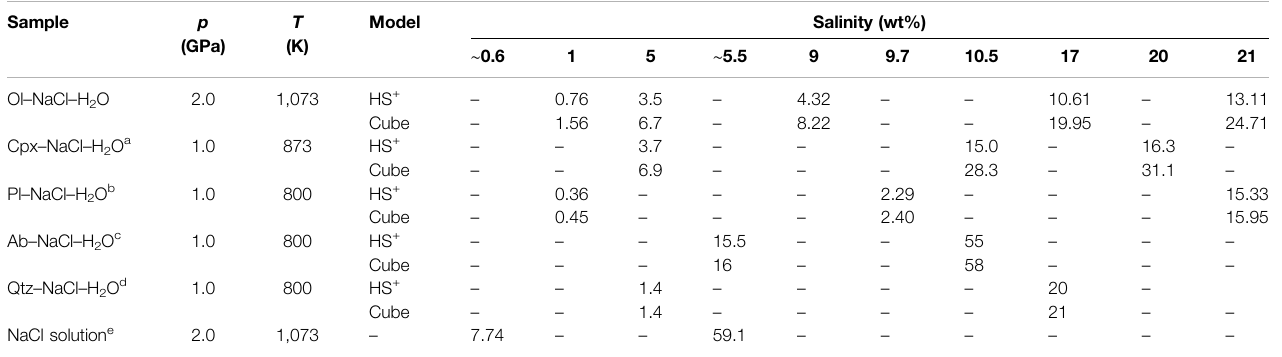
TABLE 2| Electricalconductivities(S/m)ofsaline fl uidswithvarious NaClcontentsintheOl – NaCl – H 2 O,Cpx – NaCl – H 2 O,Pl – NaCl – H 2 O,Ab – NaCl – H 2 O,andQtz – NaCl – H 2 O systems, and NaCl solutions calculated on the basis of the HS + and cube models at high temperatures and pressures.